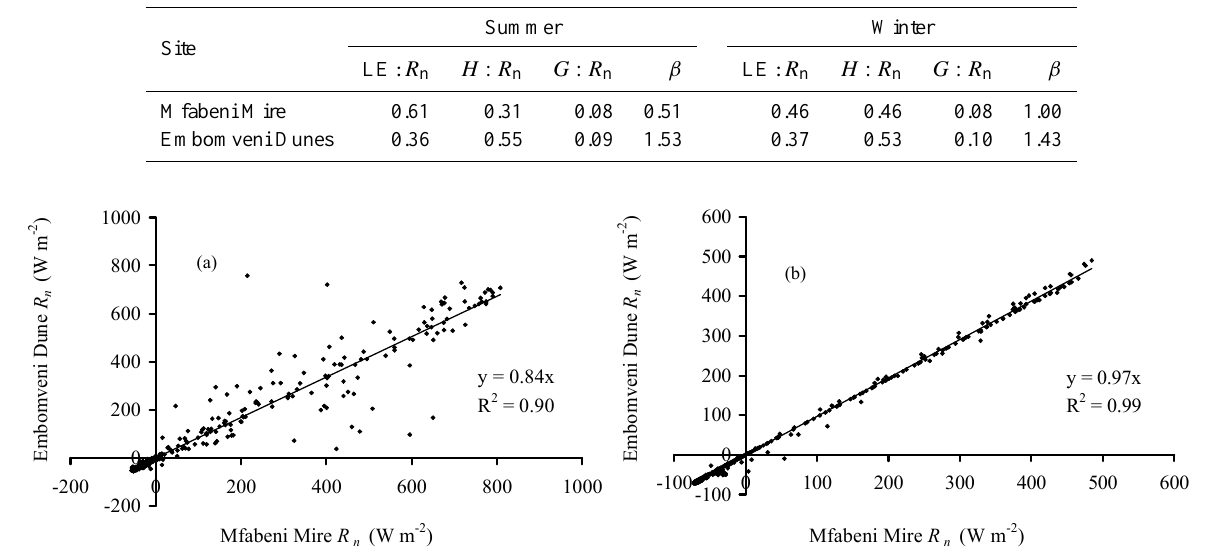
Fig. 6. The difference in summer (a) and winter (b) net radiation R n (half hourly) between the Mfabeni Mire and Embomveni Dune sites shown by the slope of the least squares linear regression.